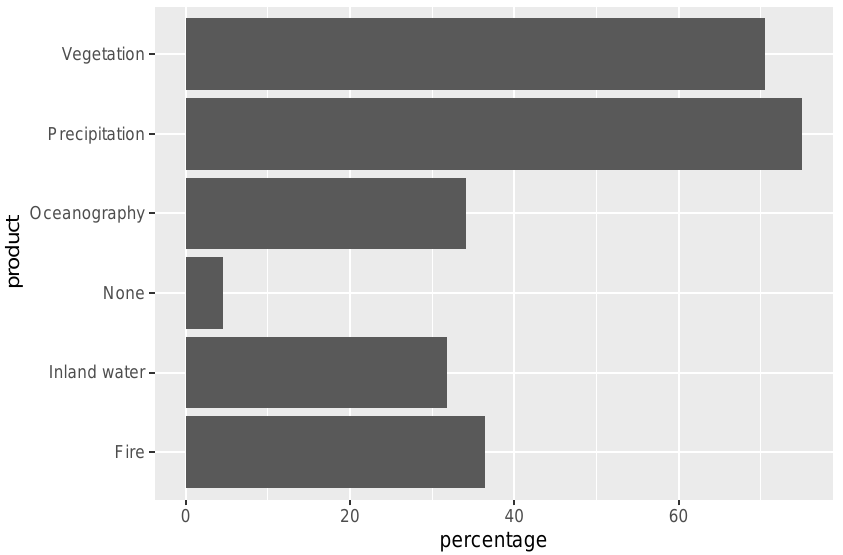
Figure 7. Responses of the question (in % of the participants), on ’What products do you use?’. Multiple answers